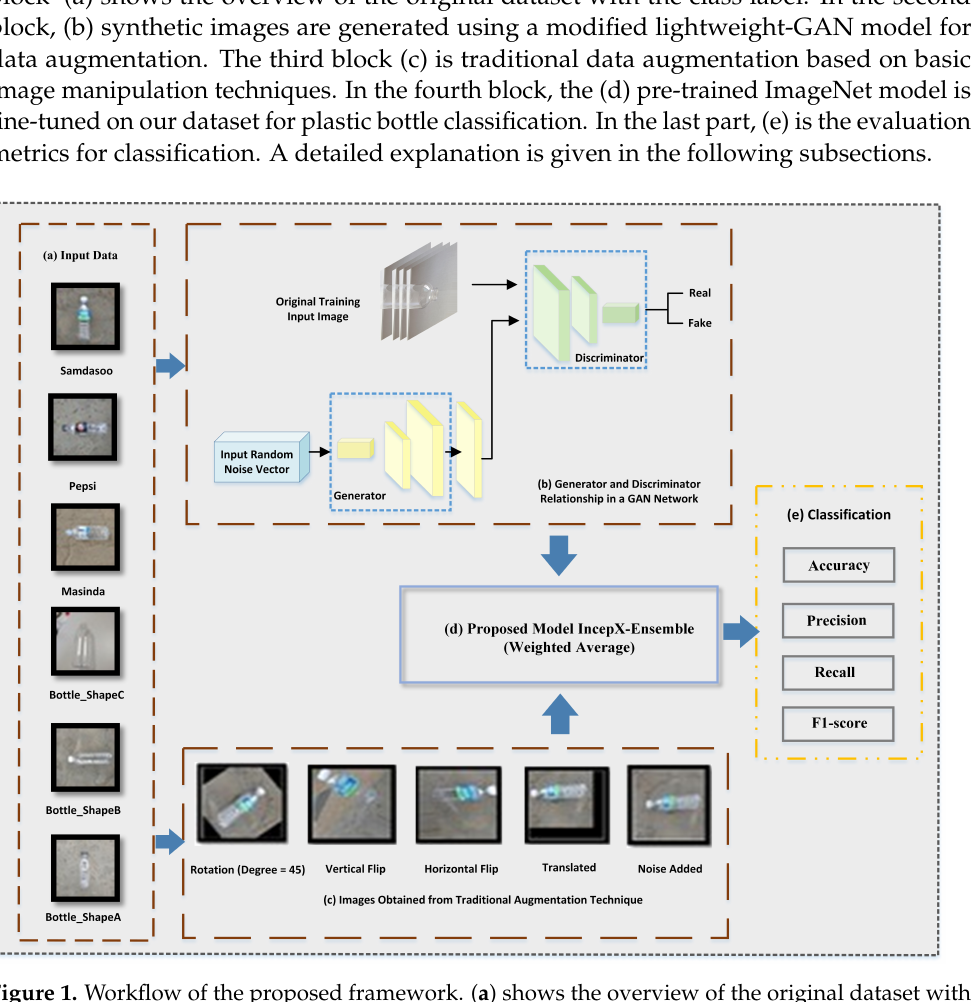
Figure 1. Workflow of the proposed framework. ( a ) shows the overview of the original dataset with the class label; ( b ) synthetic images are generated using a modified lightweight-GAN model for data augmentation; ( c ) is traditional data augmentation based on basic image manipulation techniques; ( d ) pre-trained ImageNet model is fine-tuned on our dataset for plastic bottle classification; ( e ) is the evaluation metrics for